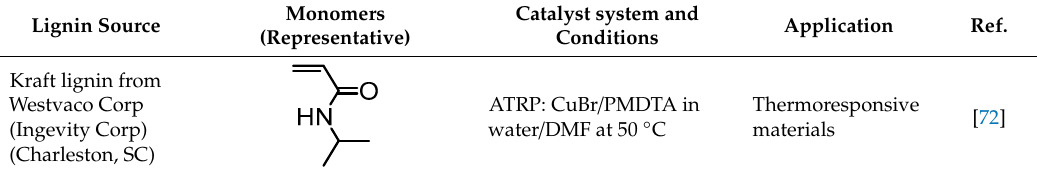
Figure 19. Proposed free radical grafting mechanism of lignin with vinyl monomers. Reproduced with permission [62].